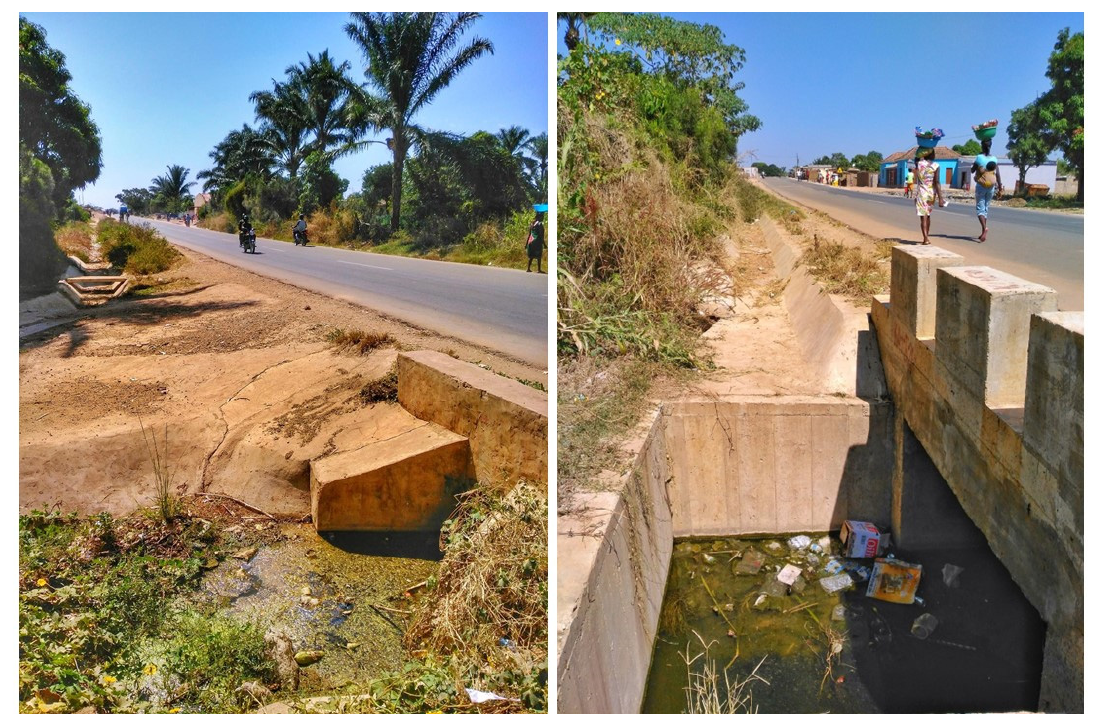
Figure 6. The new road with its drainage water collectors. Observe that in both figures, water is present despite being in the drought season.